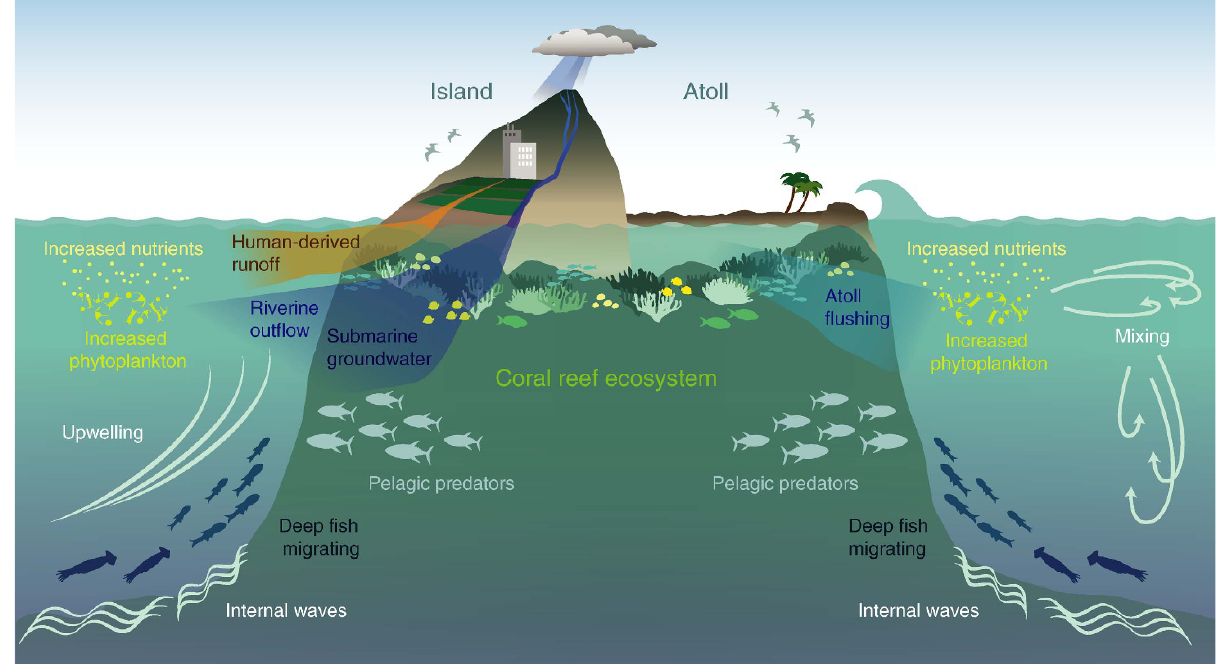
Figure 1 | The Island Mass Effect. Localized increases in phytoplankton biomass near island- and atoll-reef ecosystems—Island Mass Effect—may be the result of several causative mechanisms that enhance nearshore nutrient concentrations, including coral reef ecosystem processes, such as nitrogen fixation or decomposition, and animal waste products, such as reef-associated fishes; current-bathymetric interactions that can drive vertical transport of water masses via upwelling, downstream mixing and eddies, and internal waves; island-associated inputs, such as submarine groundwater discharge and outflow from rivers, which can mobilize and transport sediment and other terrigenous material laden with nutrients; the flushing and associated outflow of lagoonal waters from atoll environments; human-derived runoff of agricultural production, urban development and wastewater input. Enhanced nearshore phytoplankton can influence food-web dynamics and elicit a biological response in higher trophic groups, for example: horizontal and vertical migration patterns in squids, fishes and other micronekton (collectively referred to as the ‘mesopelagic boundary layer community’) that move nearshore at night to feed on increased food resources; inshore migration of pelagic predators, such as tuna, to feed on the island-associated micronekton community; greater reef fish biomass and increased cover of calcifying benthic organisms in coral reef